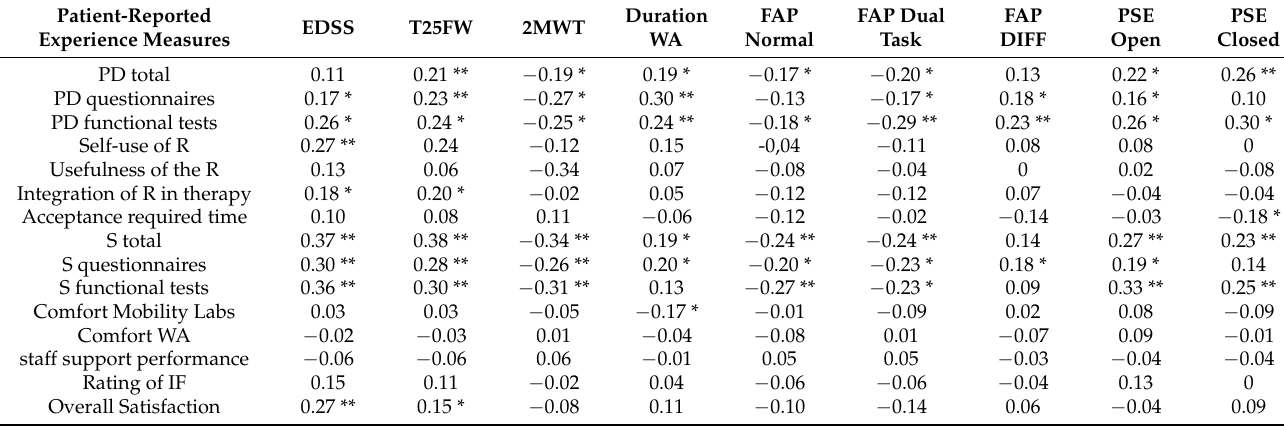
Table 5. Kendall’s Tau-b ( τ ) correlation between patient-reported experienced measures and clinical outcomes ( N = 105). Patient-Reported Experience